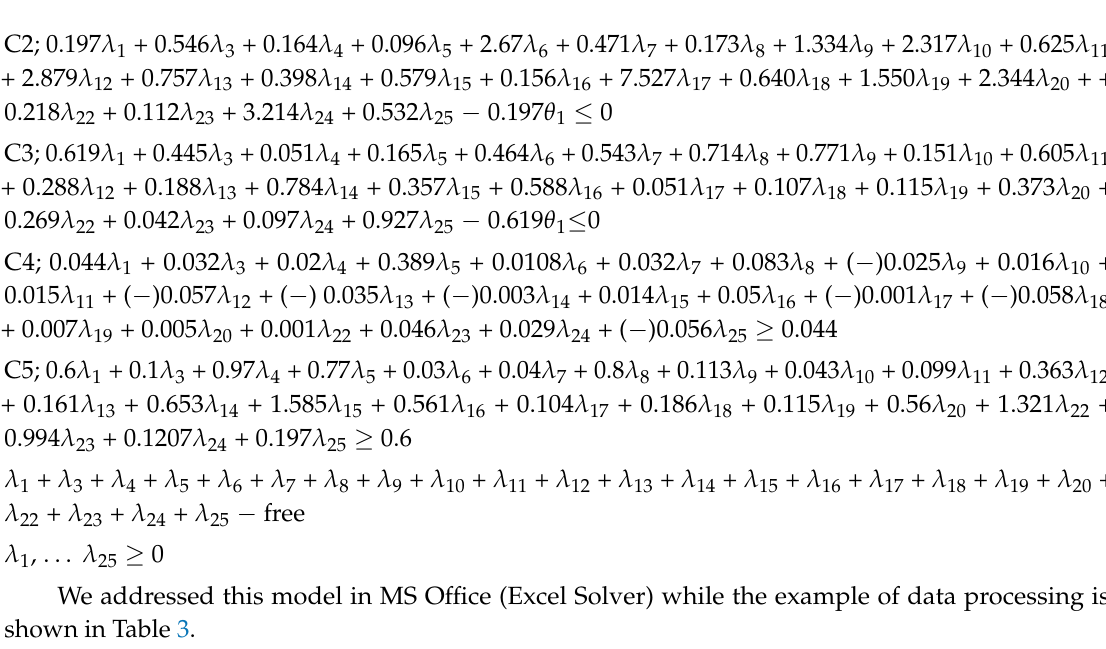
Table 3. The example of data processing in Solver.